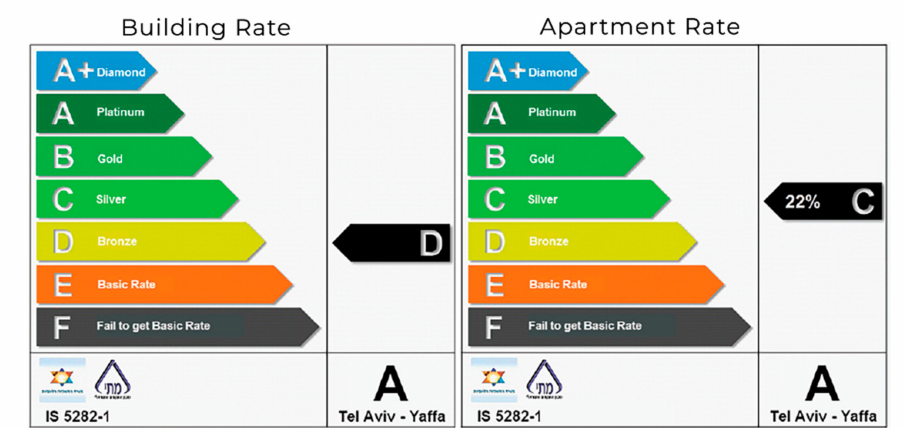
Figure 7. Energy rating for a building ( left ) and an individual unit ( right ).